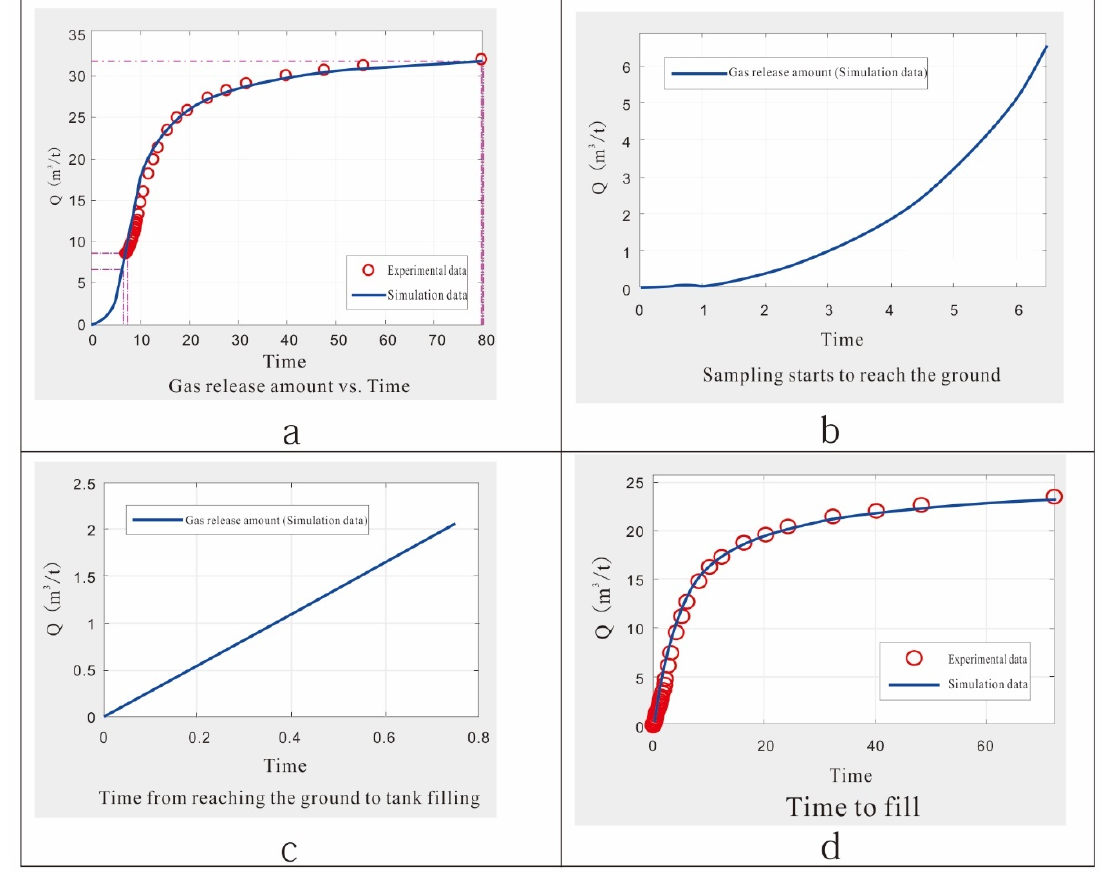
Figure 6. Interpretation Results from the New Method (( a ): Total gas production curve; ( b ): Wellbore loss stage; ( c ): Surface loss stage; ( d ): Natural desorption